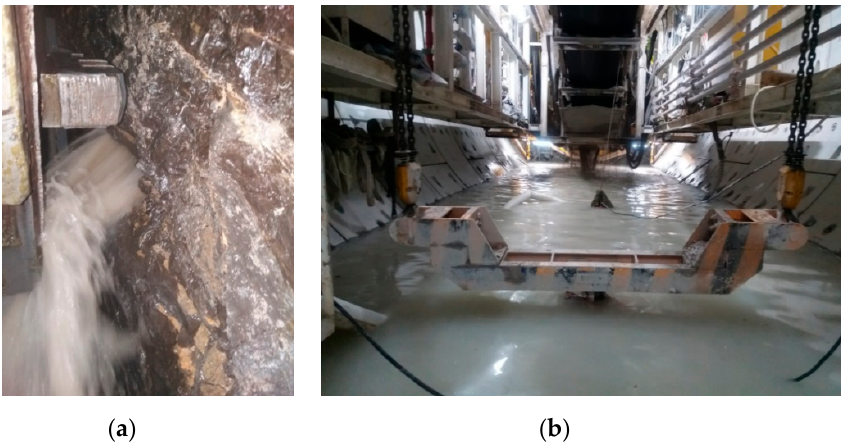
Figure 2. Water inrush from shield tunnel. ( a ) front of the tunnel; ( b ) inside the tunnel.